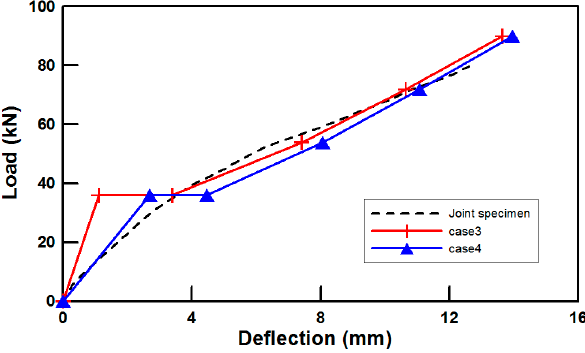
Figure 10. Load and deflection curves of Cases 3 and 4.